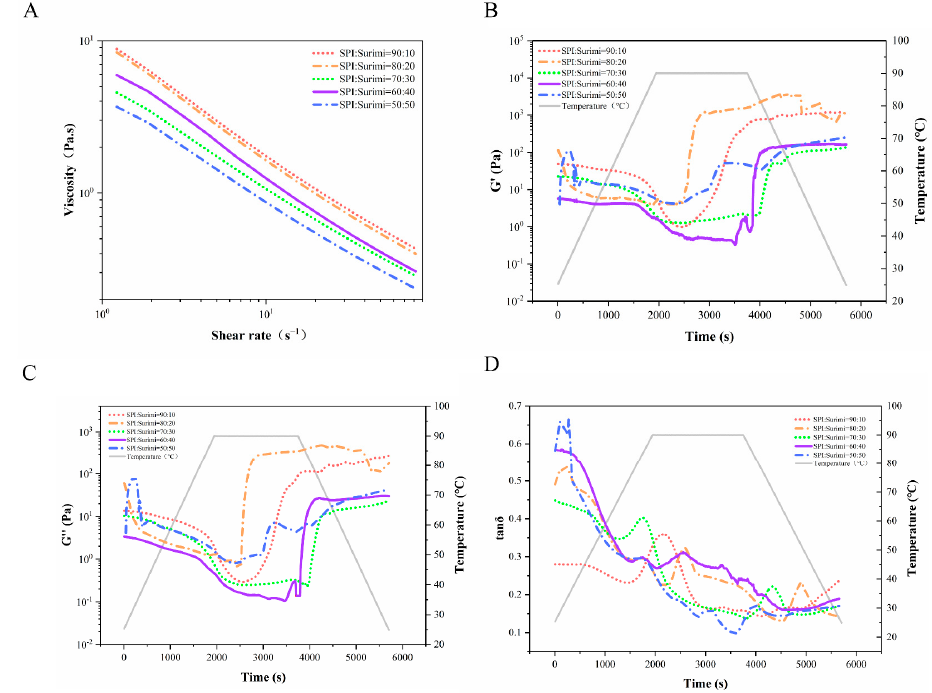
Figure 1. The viscosity ( A ), the thermal profiles in terms of storage modulus (G ′ ) ( B ), loss modulus (G ′′ ) ( C ) and tan δ ( D ) in temperature ramp for the SPI and surimi blends at different ratios.